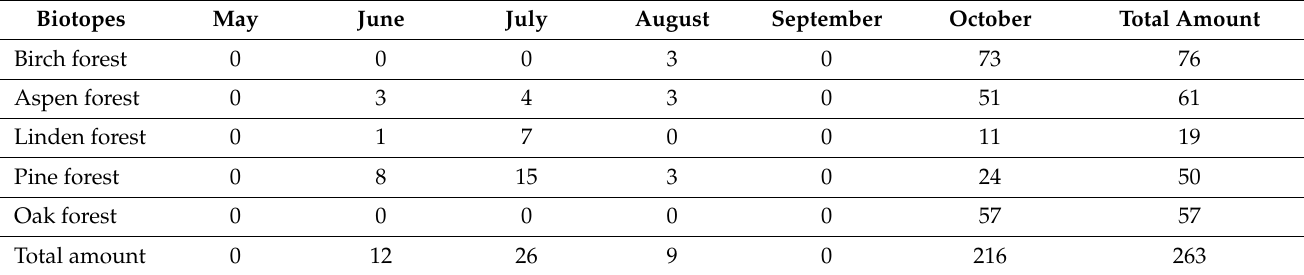
Table A7. Seasonal dynamics of Drosophila bifasciata in five biotopes.